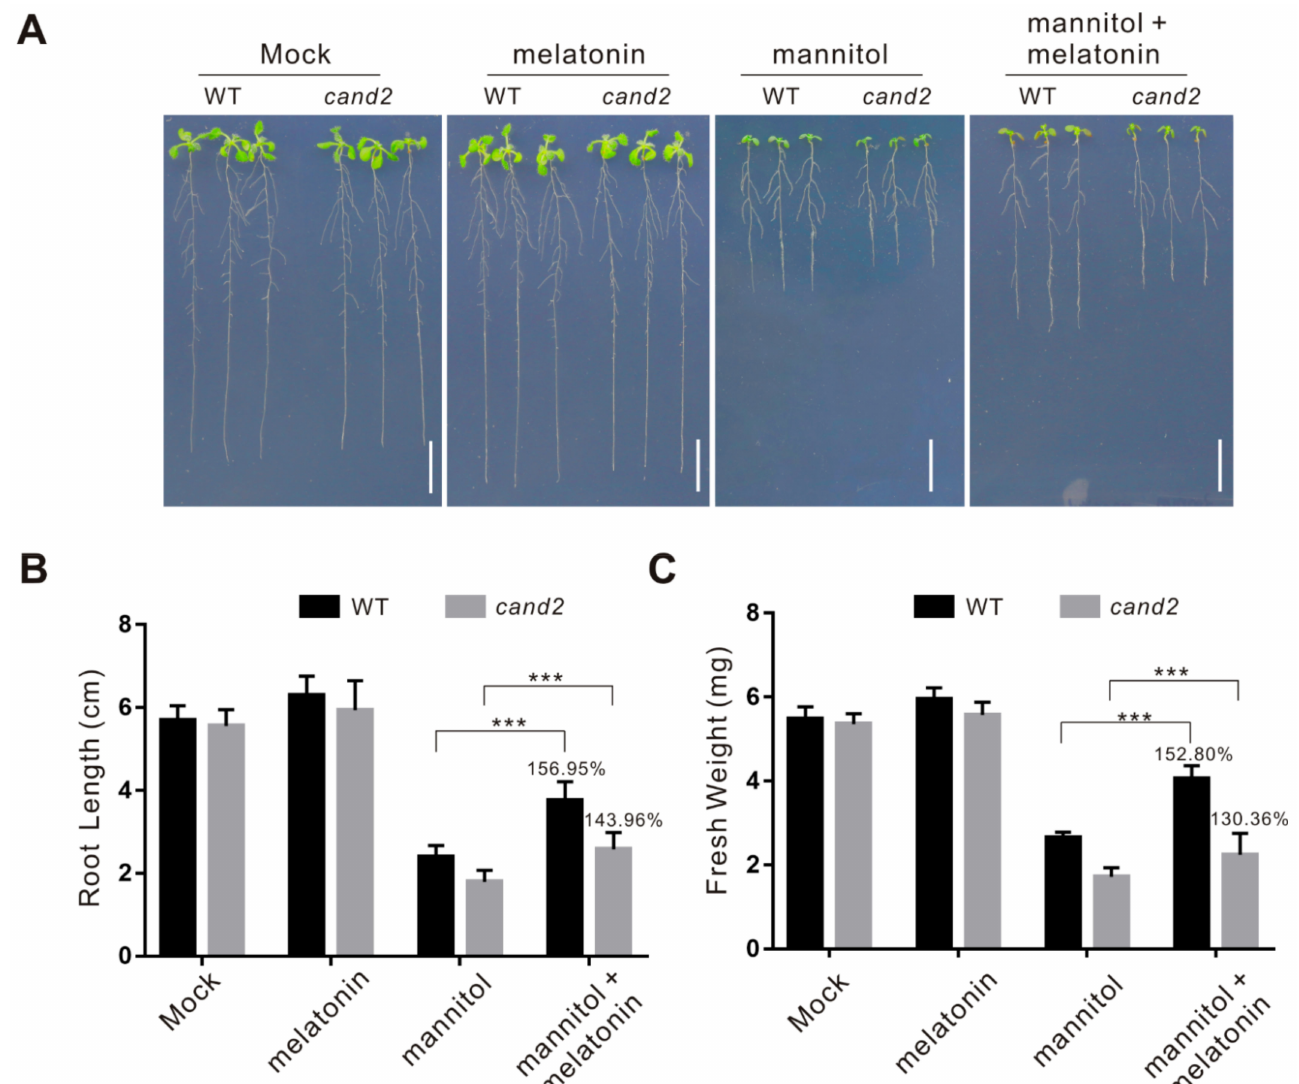
Figure 6. The cand2 mutant is sensitive to osmotic stress. ( A ) Images of 5-day-old wild-type and cand2 mutant seedlings treated with or without 300 mM mannitol in the presence or absence of 100 µ M melatonin for 5 days. Bars = 1.0 cm. ( B , C ) Root length ( B ) and fresh weight ( C ) in ( A ). The percentages in the graphs indicate the relative root length ( B ) or fresh weight ( C ) by comparing those of mannitol plus melatonin-treated plants with those of mannitol-treated plants in the presence of mannitol. The data are presented as means ± SD from at least three independent experiments ( n ≥ 30 for root length and n ≥ 10 for fresh weight). Asterisks indicate significant differences using a Student’s t -test (*** p <